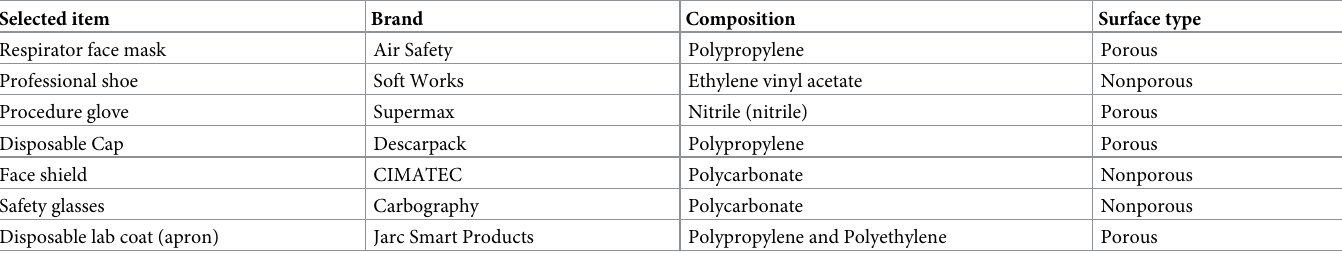
Table 1. Items used to evaluate the efficacy of instantaneous spraying of biocidal agent (0.25% sodium hypochlorite) in a disinfection chamber against the test microorganisms. Selected